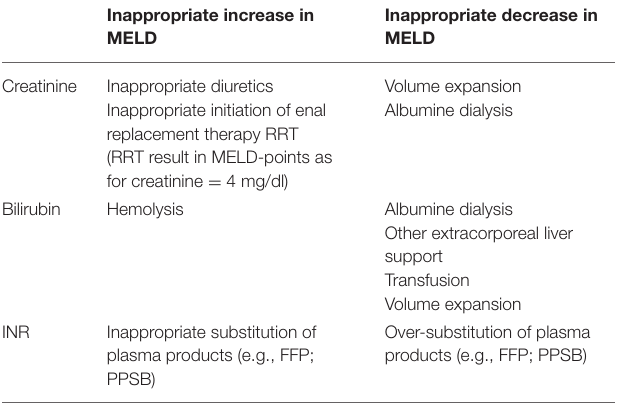
TABLE 8 | Limitations of the model of end-stage liver disease